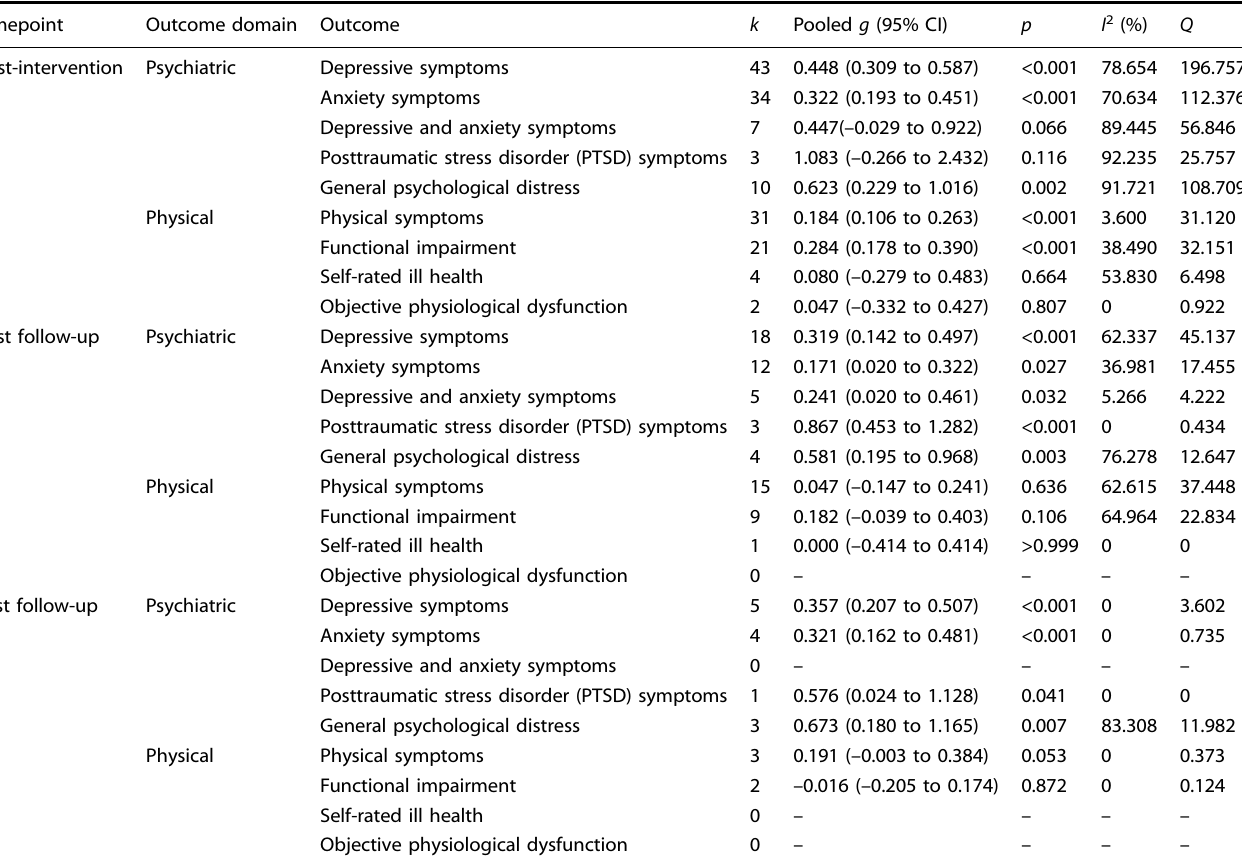
Table 2. Pooled effect sizes of IM-CBT on psychiatric symptoms and physical distress at post-intervention and follow-ups ( n = 44 studies). Timepoint